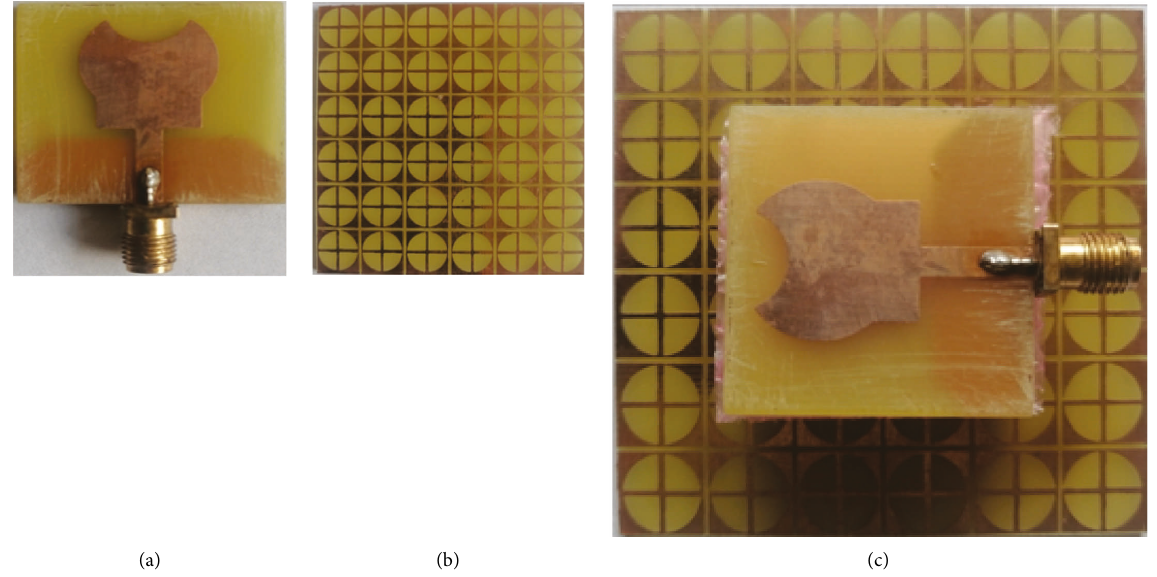
Figure 8: Fabricated prototypes for the following: (a) UWB antenna, (b) FSS reflector, and (c) UWB with FSS reflector.